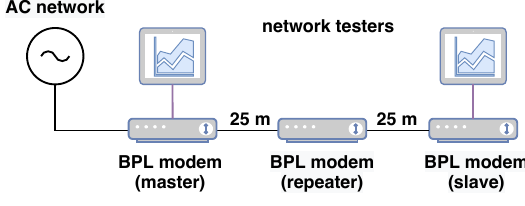
Figure 5. B1 topology—direct connection.